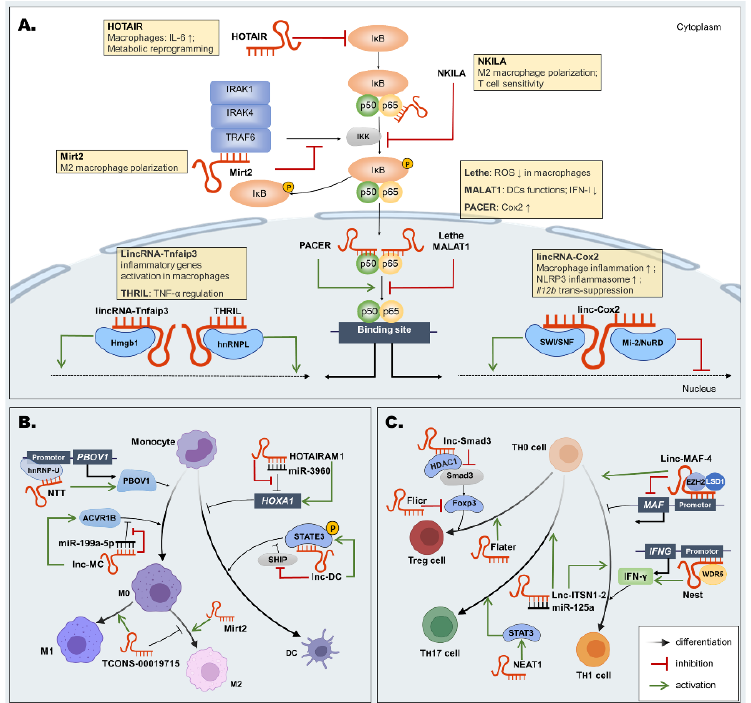
Figure 3. LncRNAs regulate NF- κ B signal transduction, immune cell differentiation, and activation.